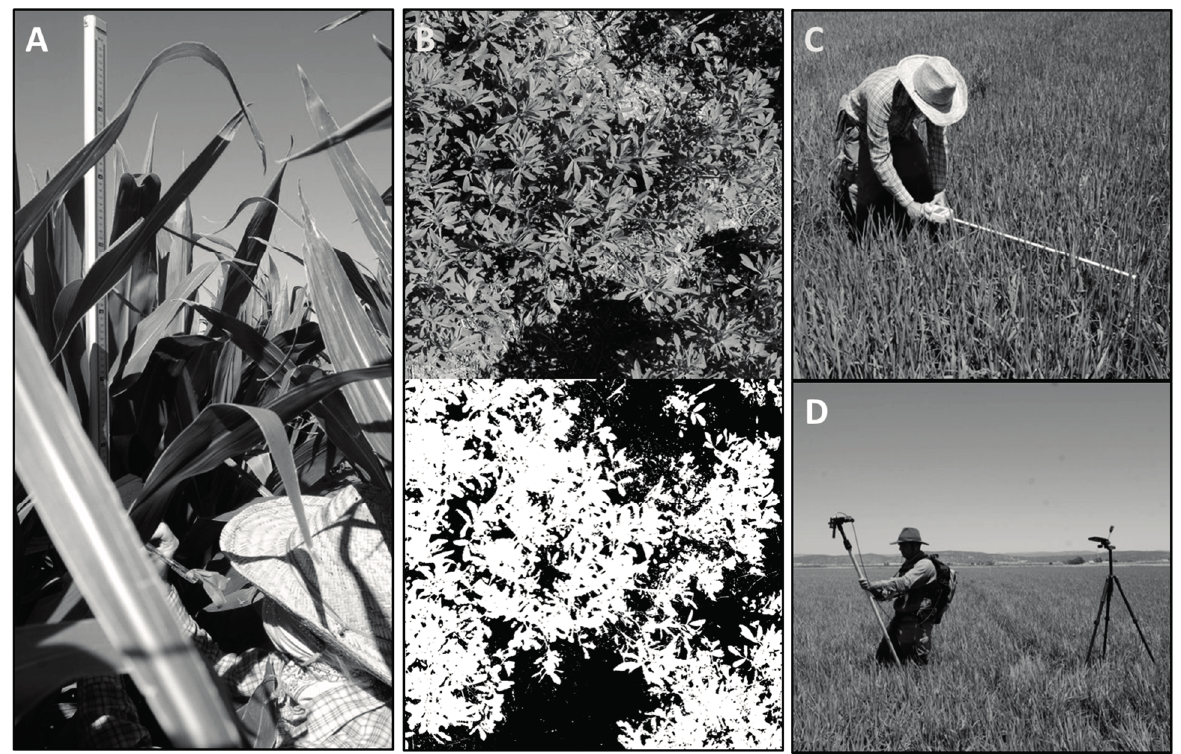
Figure 2. Non-spectroradiometric and spectroradiometric measurements used to predict aboveground wet biomass: ( A ) height (cm) using a measuring stick or telescoping rod; ( B ) fraction of vegetation cover derived from red-green-blue photos (in this case the excess green minus excess red index); ( C ) gap fraction and leaf area index derived from a ACCUPAR LP-80 ceptometer; and ( D ) hypersepctral narrowbands retrieved from an Analytical Spectral Devices Field Spec Pro 3 and white reflectance mounted to a